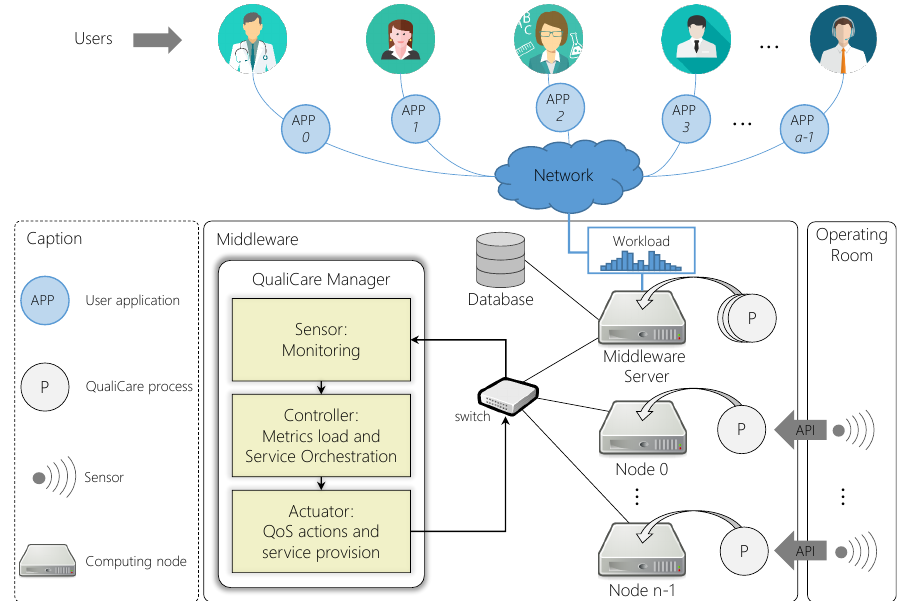
Figure 5. QualiCare closed-loop model with a Manager in charge of monitoring and adapting the middleware according to the workload. At the user perspective, a denotes the number of user applications. At the middleware perspective, n denotes the number of nodes running a QualiCare process that acquires data from sensors in the